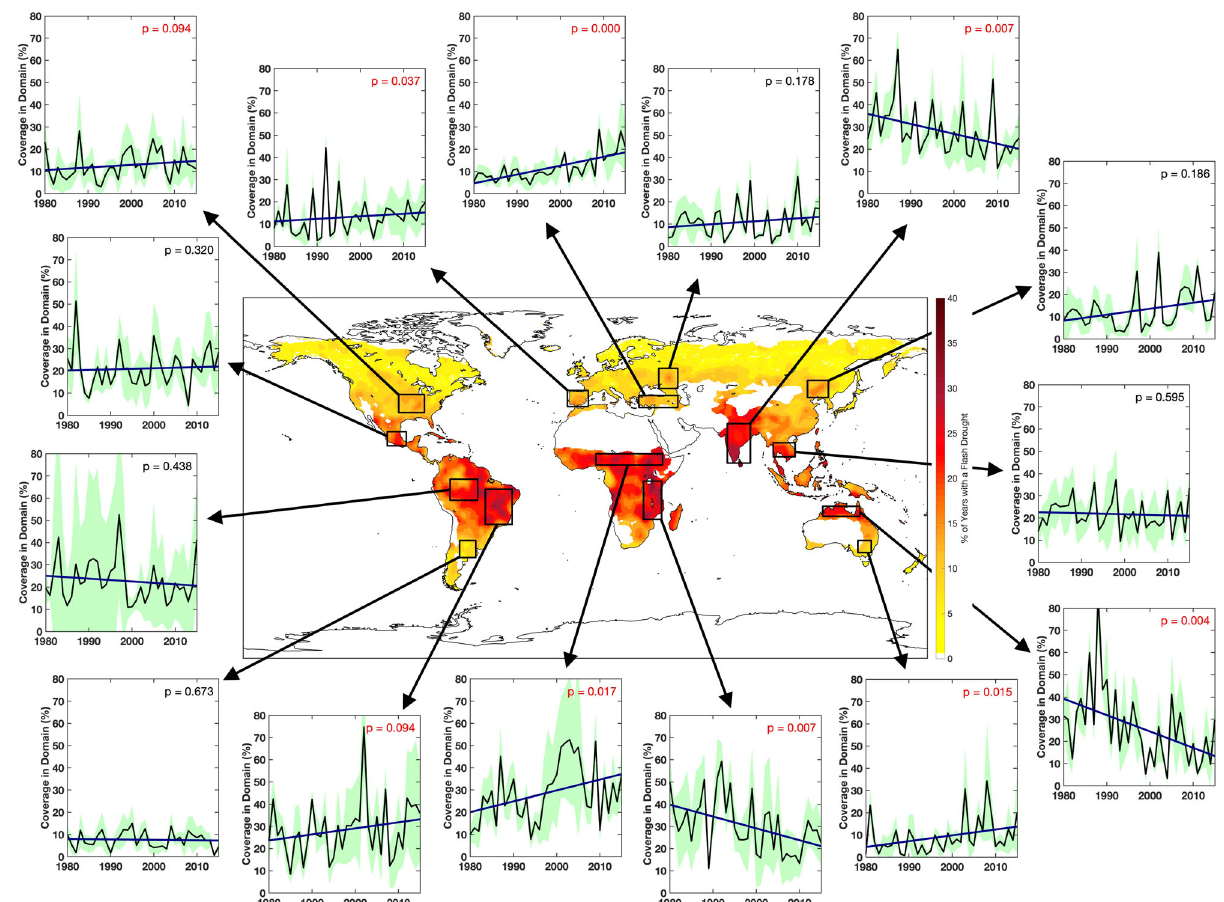
Fig. 3 Trends in fl ash drought occurrence. Mean fl ash drought spatial coverage (percent) from the four reanalysis data sets (black line) for each of the domains outlined in black on the map. The green shaded area represents the variability (standard deviation) between the four reanalyses and the thicker blue line represents the trend line for fl ash drought spatial coverage. p -values highlighted in red are statistically signi fi cant trends at the 90% con fi dence level using the Mann – Kendall